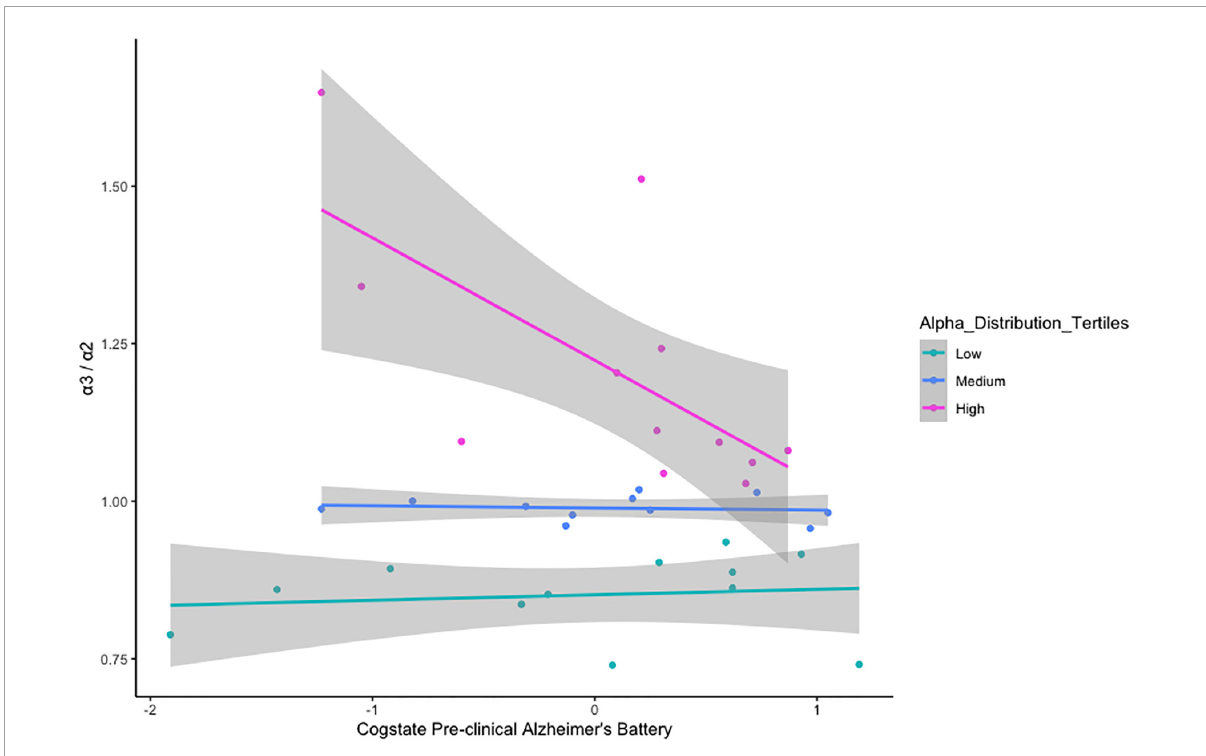
FIGURE5 Correlations between the Pre-clinical Alzheimer’s Battery and α 3/ α 2 ratios stratified by tertiles.